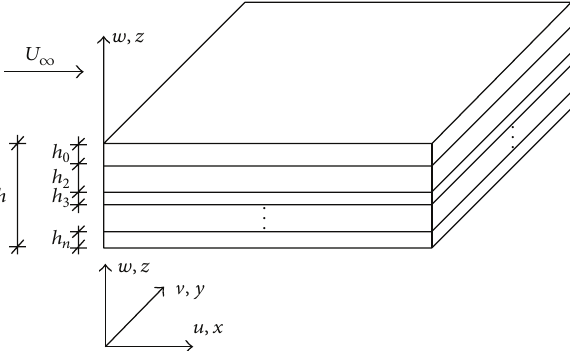
Figure 2: View of the anatomy of the composite ply